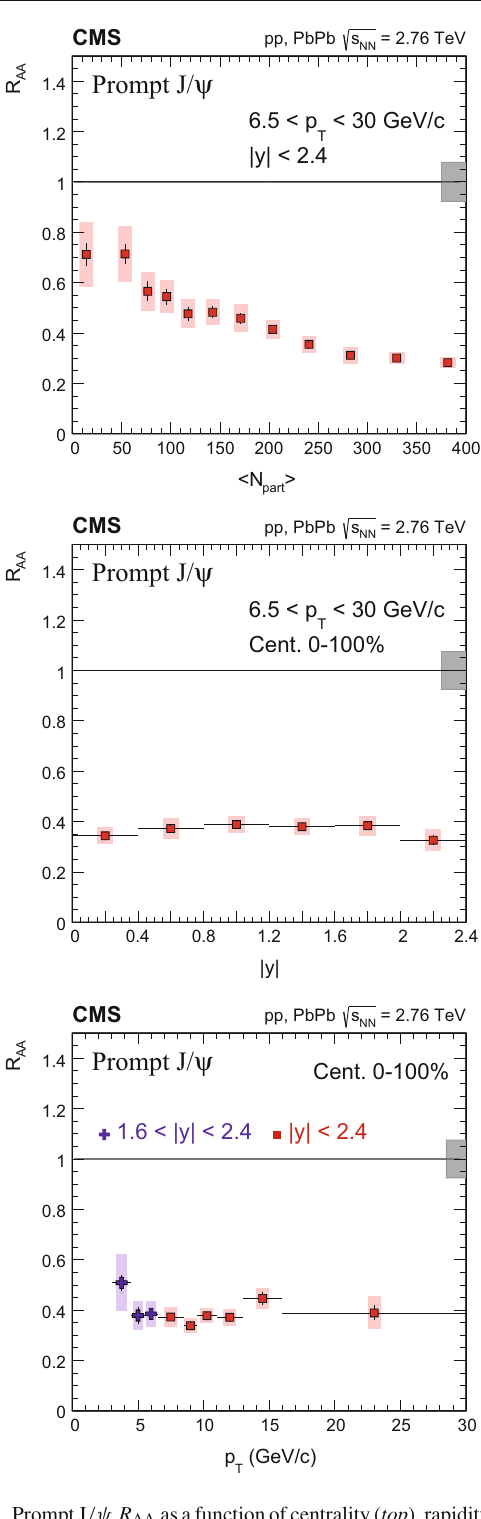
Fig. 4 PromptJ /ψ R AA asafunctionofcentrality( top ),rapidity( mid- dle ),and p T ( bottom ).The bars ( boxes )representstatistical(systematic) point-by-point uncertainties. The gray boxes plotted on the right side at R AA = 1 represent the scale of the global uncertainties. The average N part values correspond to events flatly distributed across